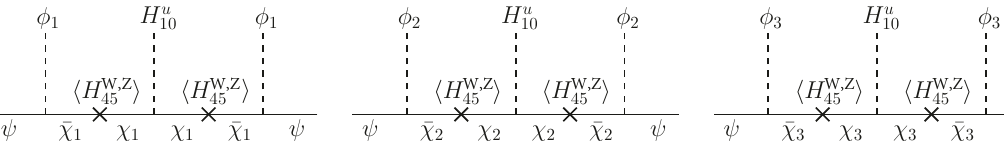
Figure 1. Diagrams coupling